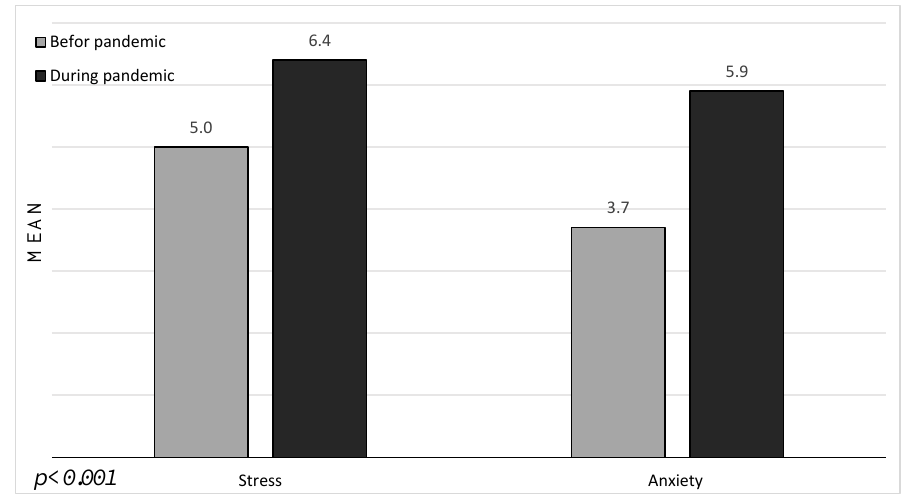
Figure 2. Mean overall stress and anxiety scores before and during the pandemic. Int. J. Environ. Res. Public Health 2020 , 17 , x